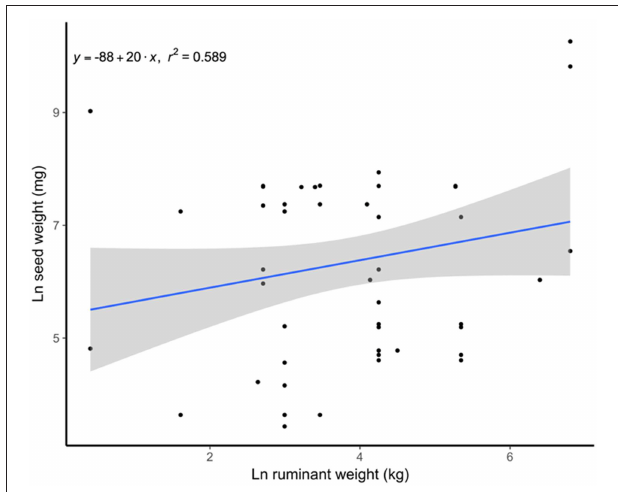
FIGURE 2 | Positive relationship between the weight of spat seeds and the size of the spitter ruminants. Data from Table S1